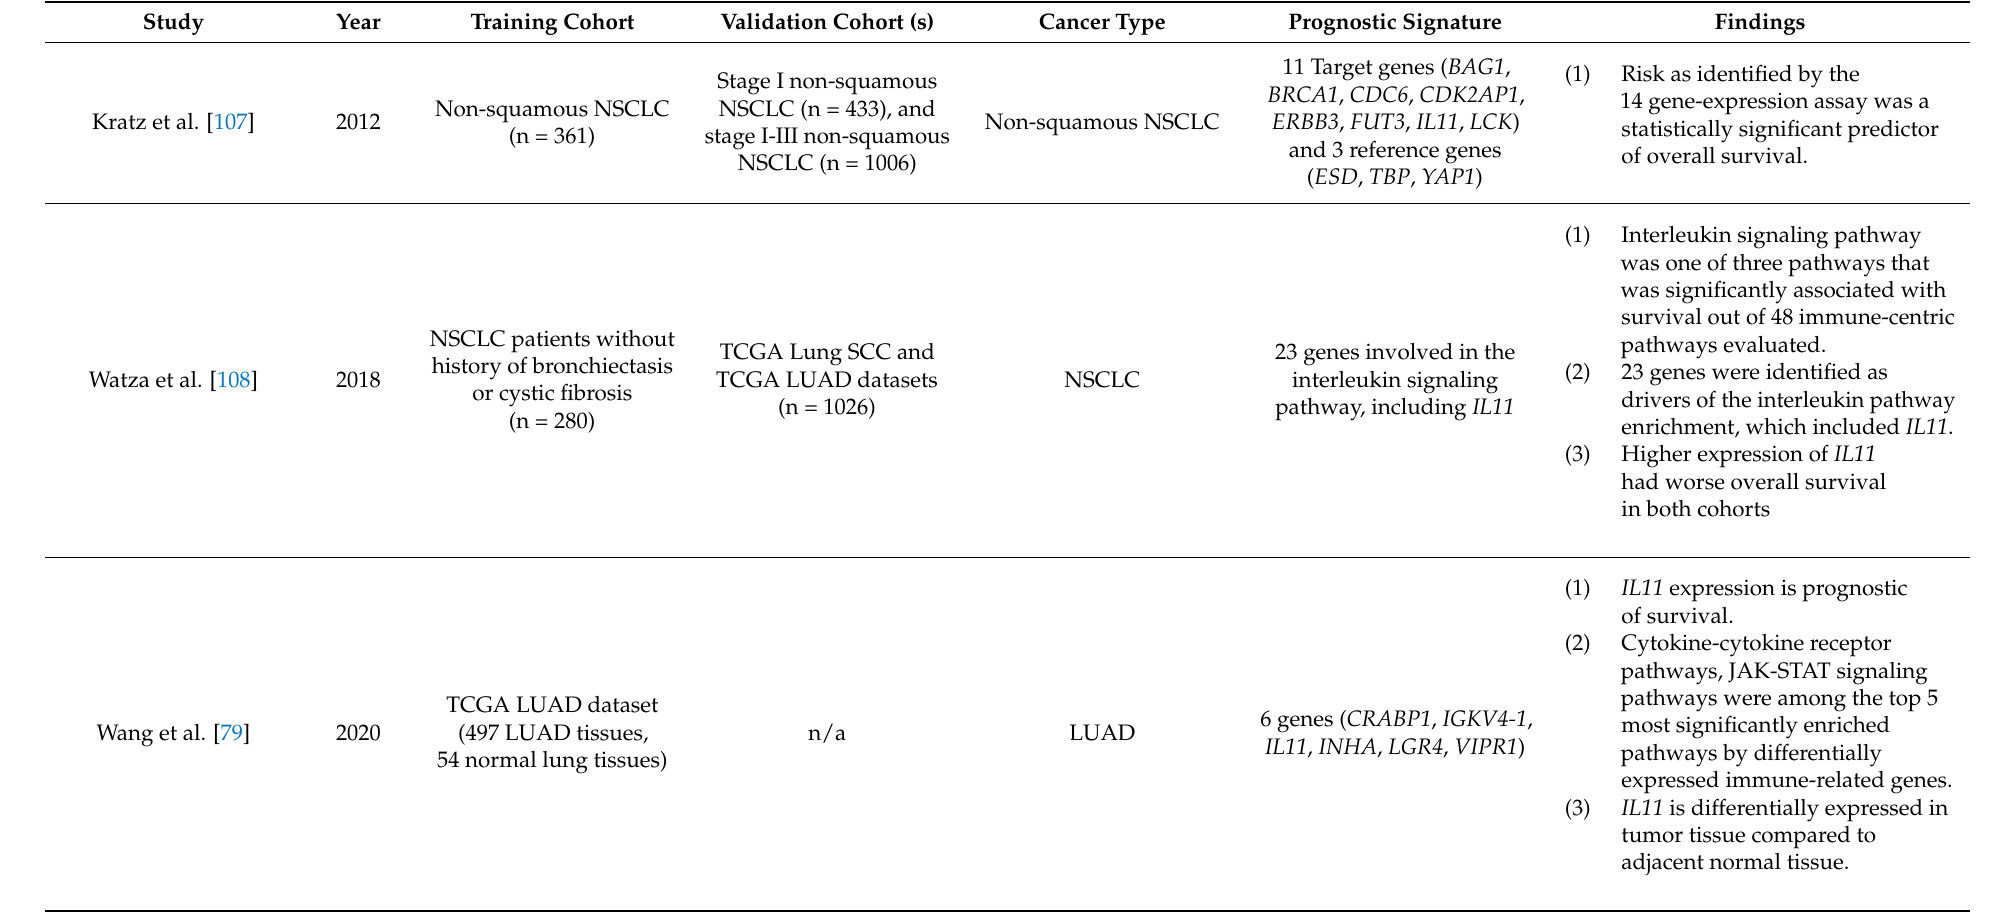
Table 4. Studies identifying IL11 as a prognostic